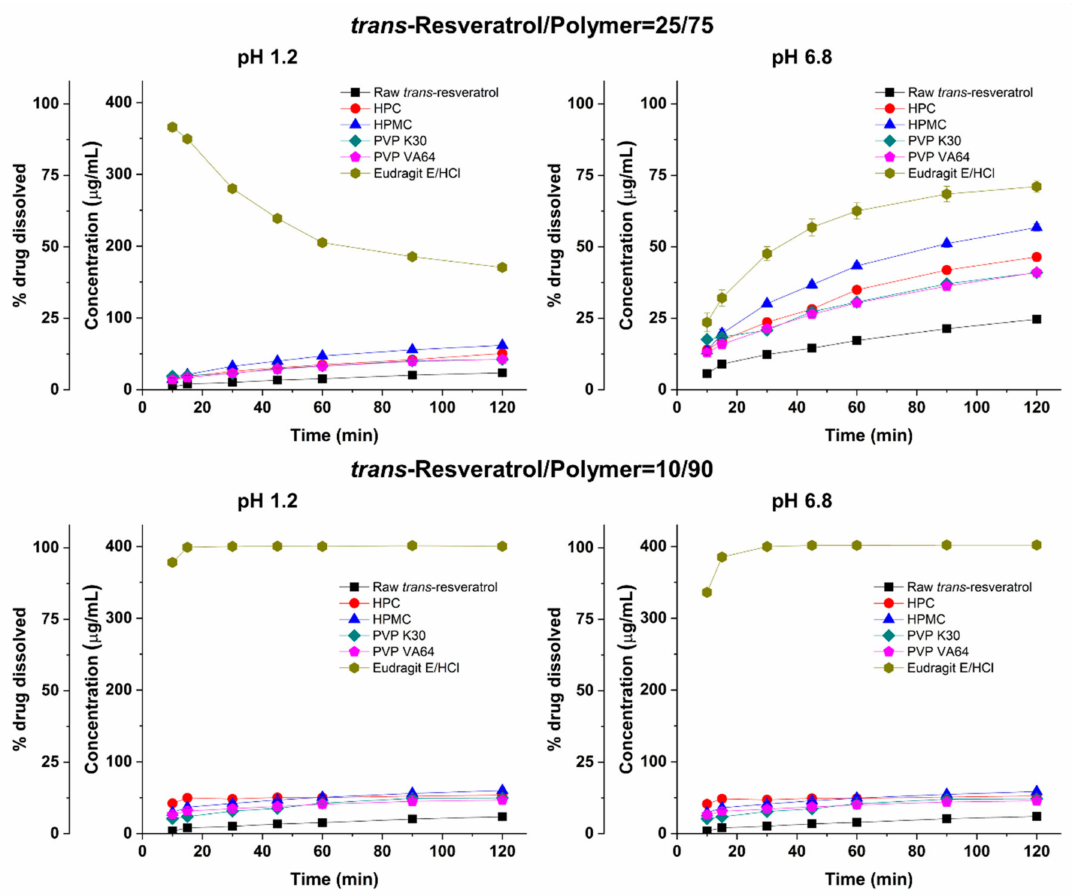
Figure 3. Dissolution profiles of raw trans -resveratrol and solid dispersion powders produced using the spray drying process in pH 1.2 and 6.8 dissolution